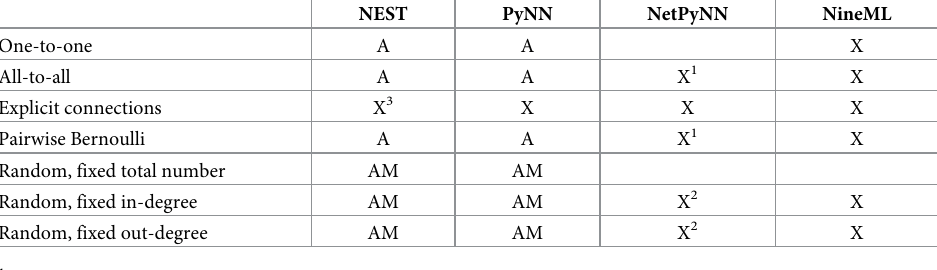
Table 1. Connectivity rules present in a selection of languages and simulators. X: The rule is supported, A: The rule is supported and it is possible to specify whether autapses are created or not, M: Ditto for multapses. NEST PyNN NetPyNN